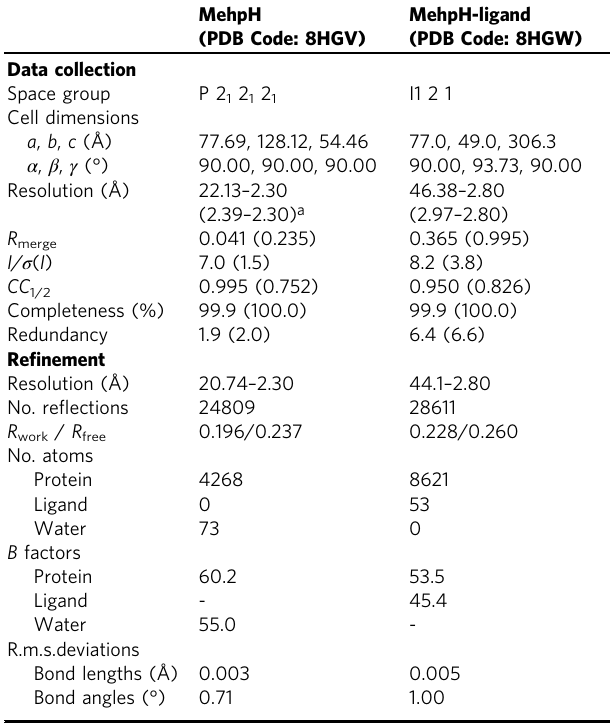
Table 1 Data collection and re fi nement